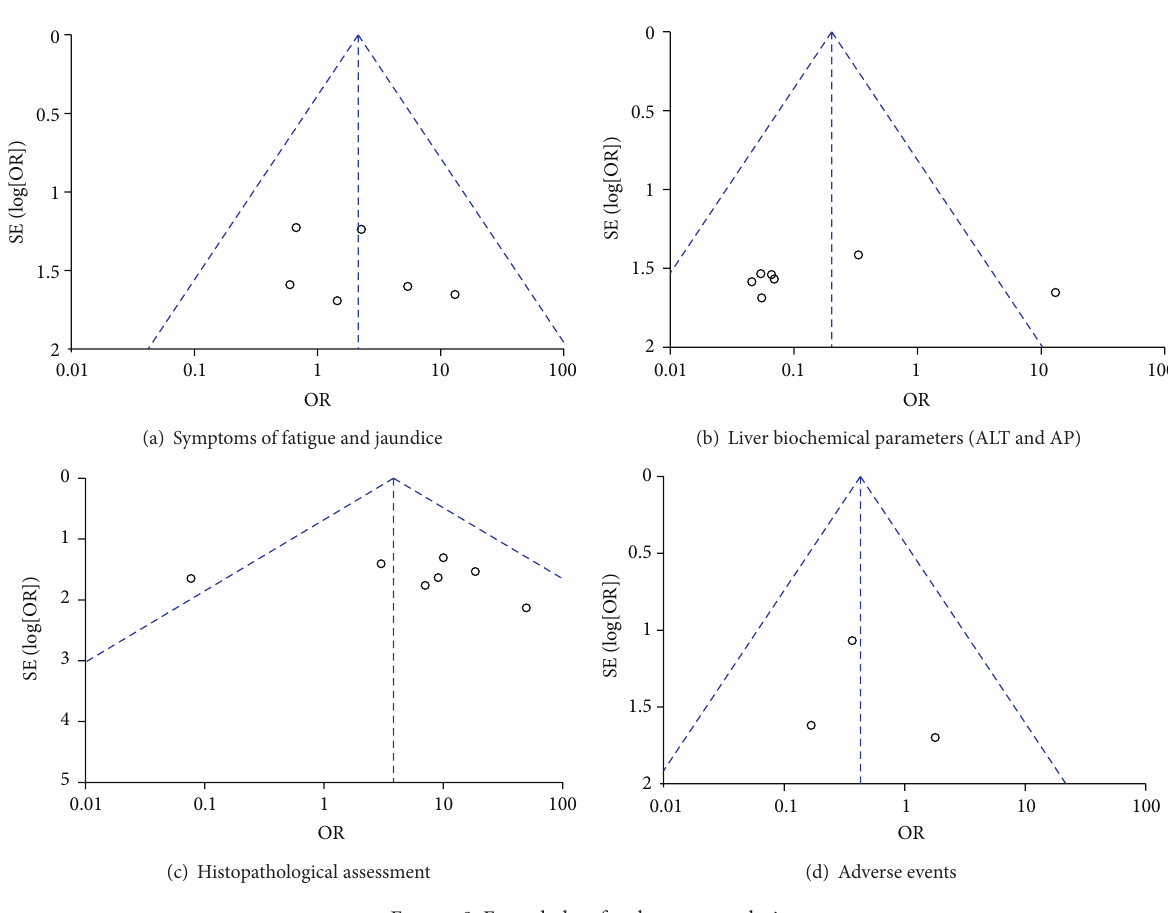
Figure 9: Funnel plots for the